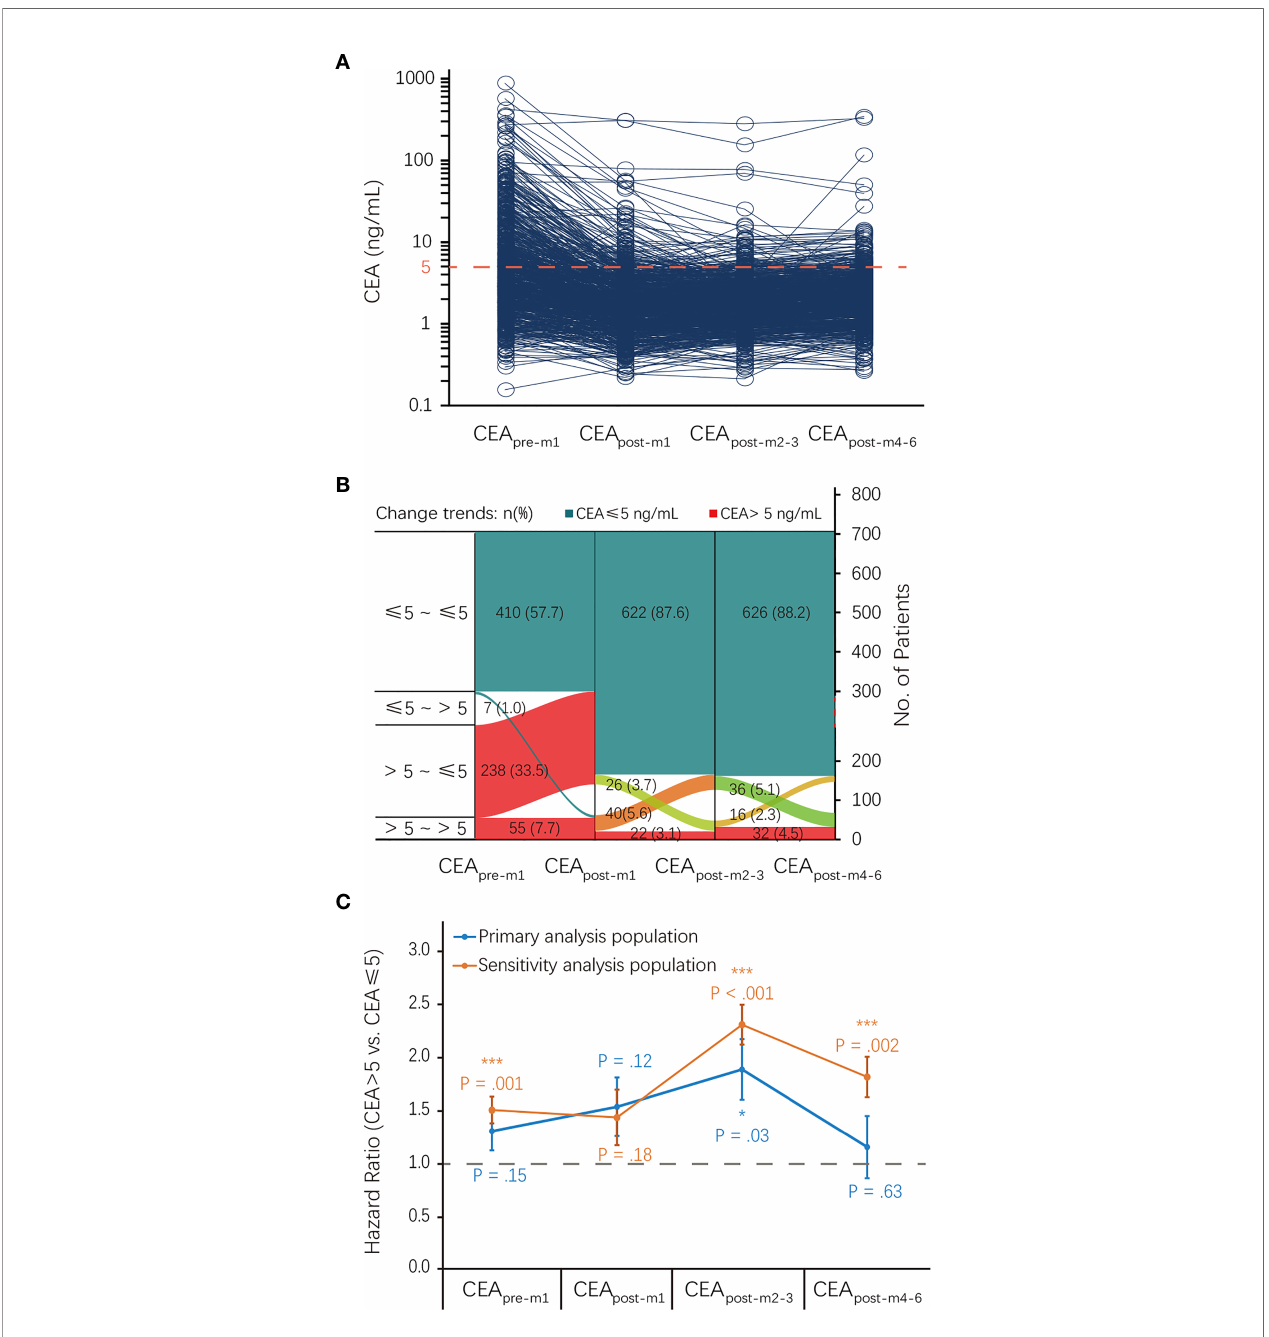
FIGURE 2 | CEA status at different perioperative time points and its association with RFS. (A) CEA levels of each patient at different perioperative time points. (B) The proportion of patients with elevated CEA levels at different perioperative time points. (C) Association of CEA status at different perioperative time points with RFS. CEA, carcinoembryonic antigen; CI, con fi dence interval; HR, hazard ratio; RFS, recurrence-free